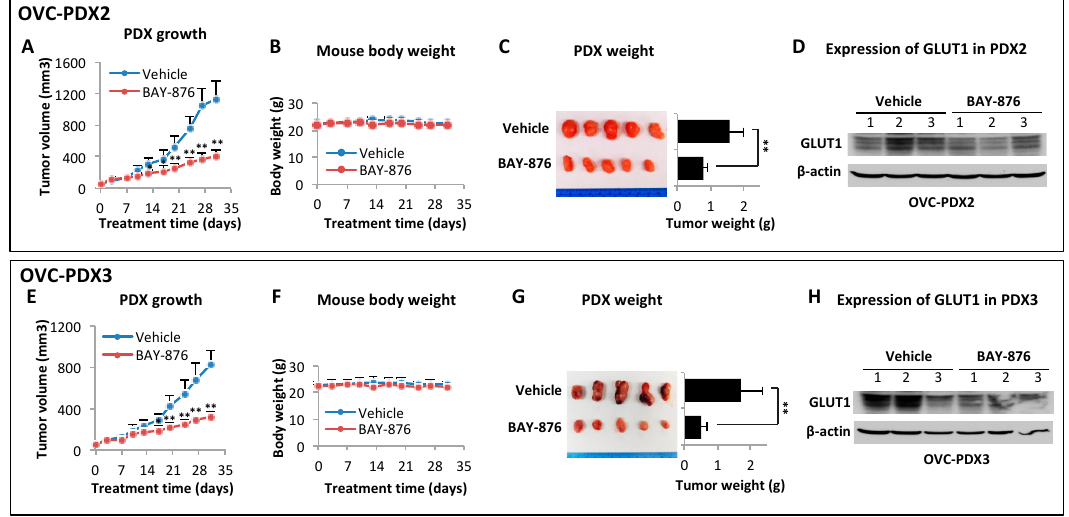
Figure 6. BAY-876 suppresses ovarian cancer PDXs in mice. Two serous ovarian carcinoma PDXs grown s.c. in female NSG mice were treated for 30 days with BAY-876 (4 mg/kg/day). Data shown were growth curves of tumor volumes ( A,E ), body weights over the course of experiment ( B , F ), images and weights of end point xenografts ( C,G ) and immunoblotting analysis of GLUT1 protein expression in PDXs from 3 vehicle- and 3 BAY-876-treated mice ( D , H ). ** p < 0.01.